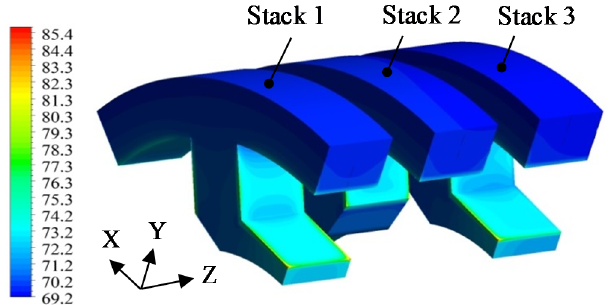
Figure 14. Temperature field distribution of the stator core (in